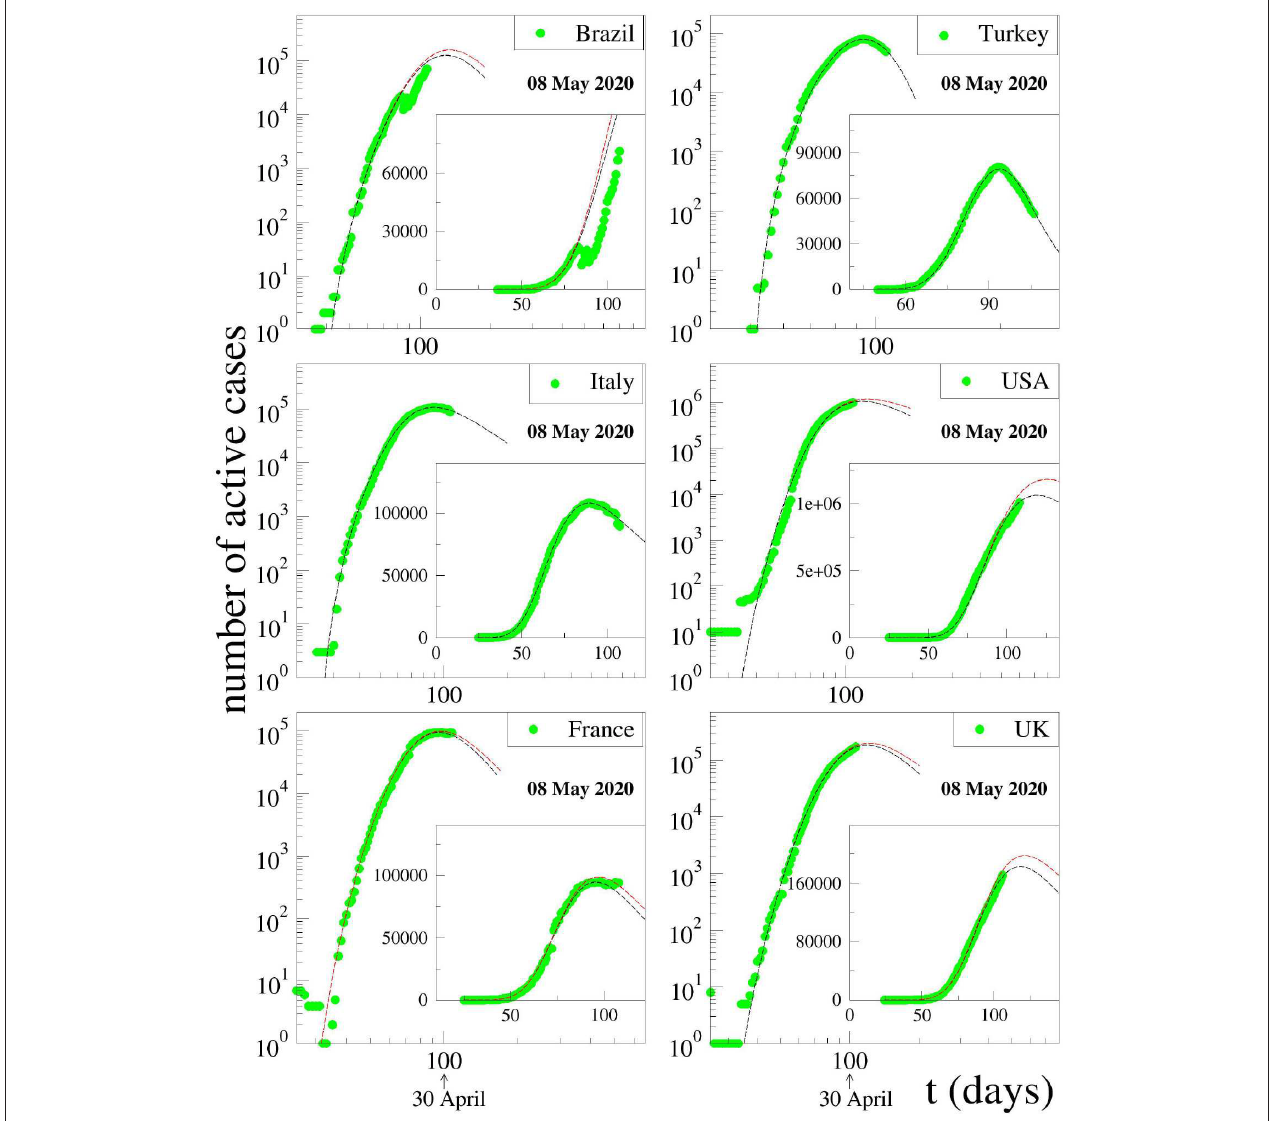
FIGURE 2 | Fits of the data for active cases available on 08 May 2020 for various severely affected countries around the world with Equation (1). The fitting parameters γ and q are fixed at the values for China for all countries that have not yet reached their peak values. Notice that, in the case of Brazil, a disruption occurred in the publicly available data in mid-April. We do not know the cause of this. Coincidentally, however, precisely at that time, the President of Brazil decided to change his Minister for